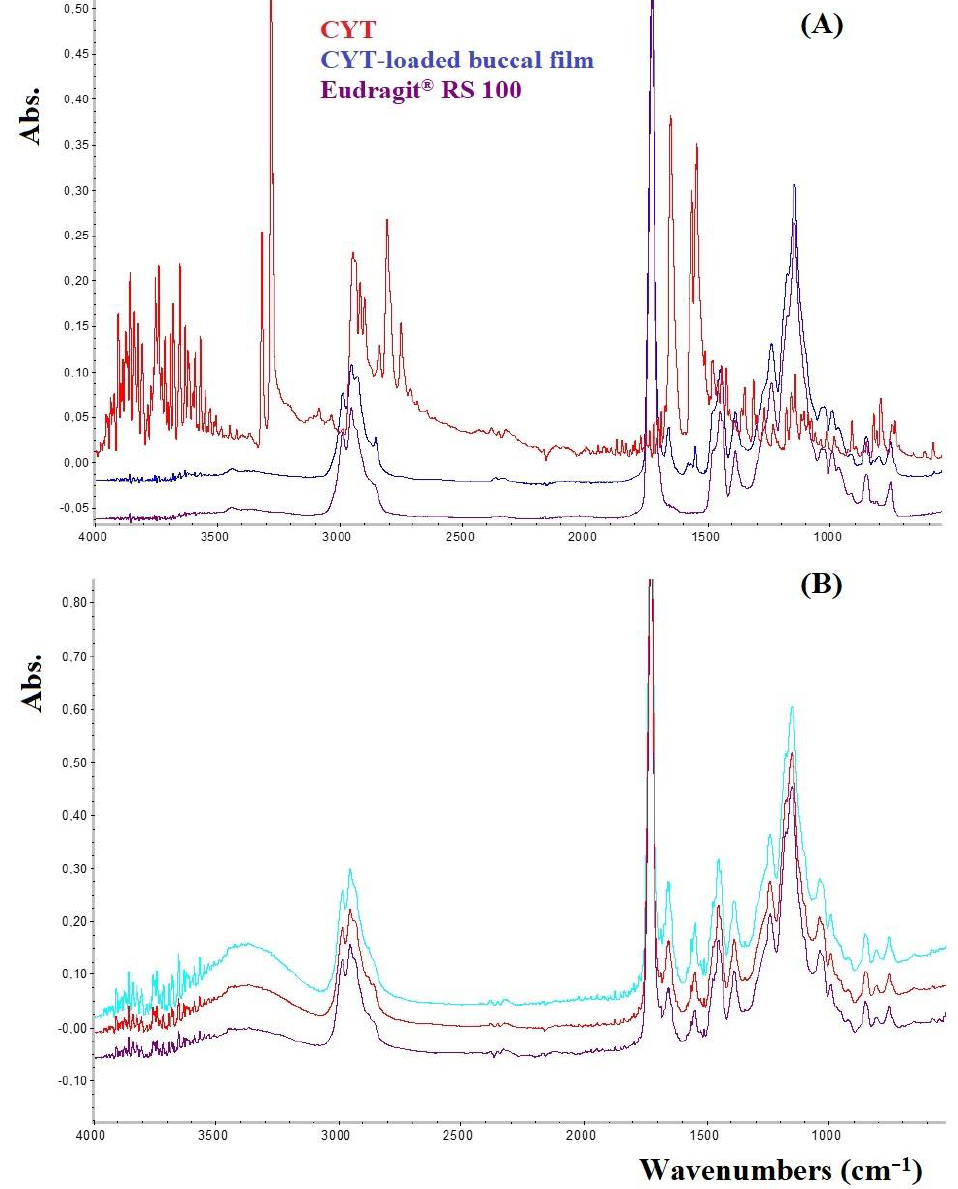
Figure 2. ( A ) FTIR in ATR mode spectra of pure CYT (red), Eudragit ® RS100 (purple) and Film B (blue) reported as a representative example for all the prepared film. ( B ) FTIR in ATR mode spectra recorded by analyzing different three portions of Film B.